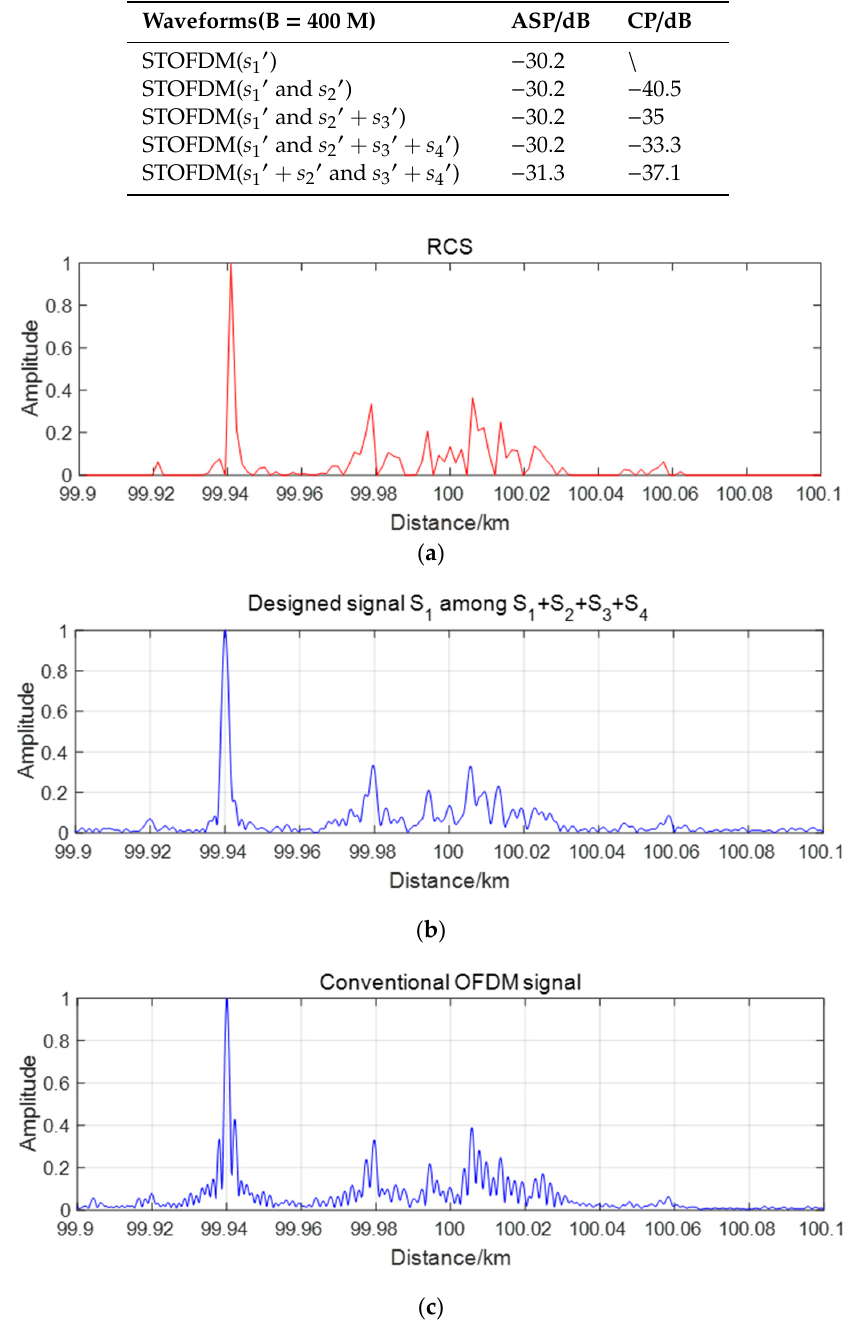
Figure 15. One-dimensional range image. ( a ) One-dimensional radar cross section (RCS) range images; ( b ) Designed signal s 1 (cid:48) during total signal s 1 (cid:48) + s 2 (cid:48) + s 3 (cid:48) + s 4 (cid:48) in MIMO; ( c ) Conventional OFDM signal in SISO. Table 6. Range peak sidelobe ratios (RPSLR) of previous and designed STOFDM signals in single input single output (SISO) and MIMO radar.